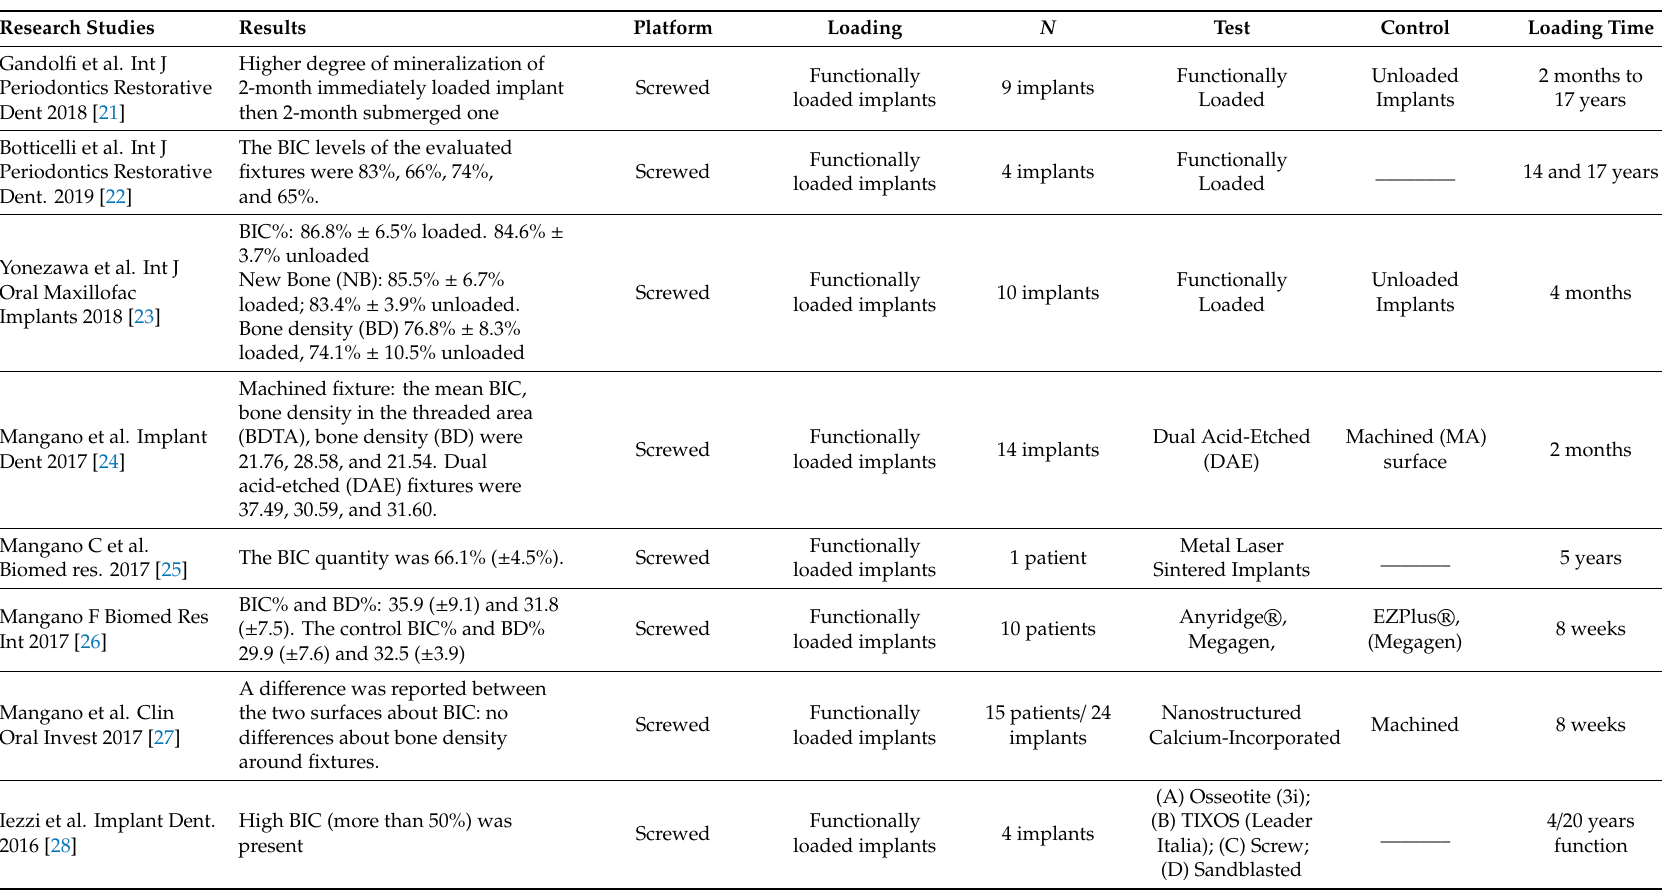
Table 1. Summary of the research studies characteristics evaluated in the investigation: The implant loading protocol and the total loading time were presented in the